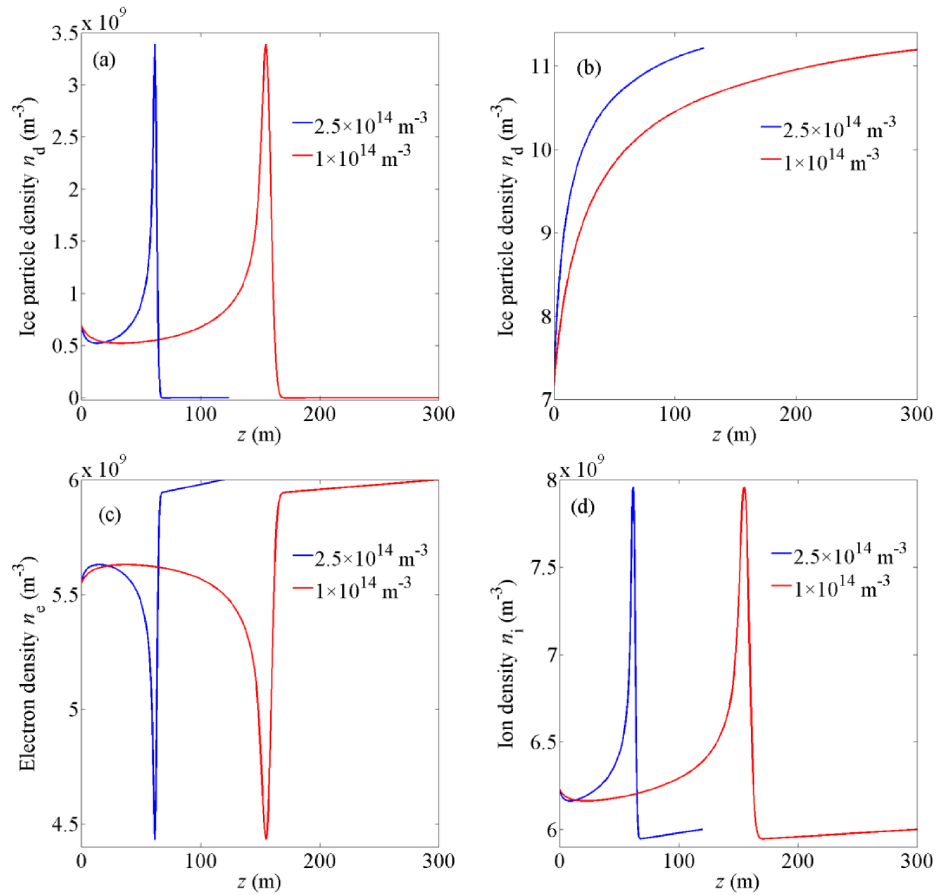
Figure 9. The distribution of (a) ice particle density, (b) the averaged particle radius, (c) electron density, and (d) ion density for various water vapor densities near the lower boundary of the condensation